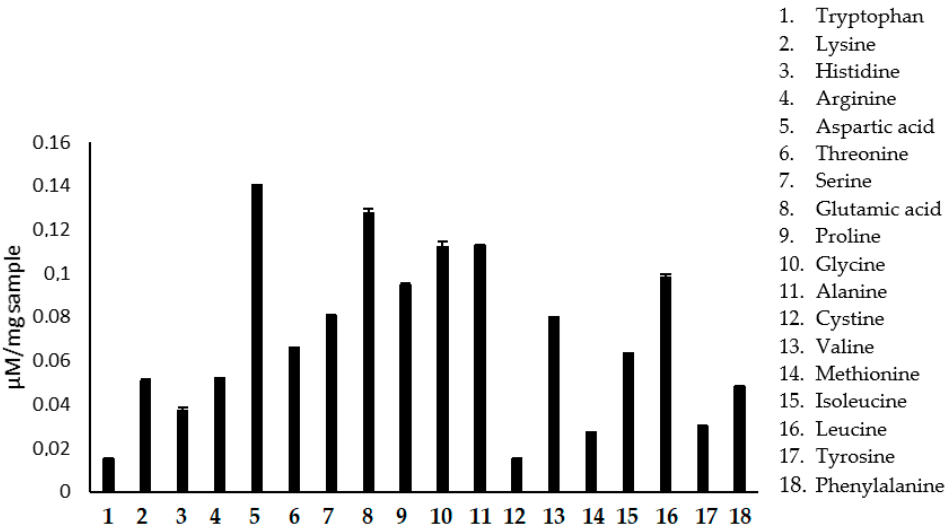
Figure 2. Amino acid composition of pollen.